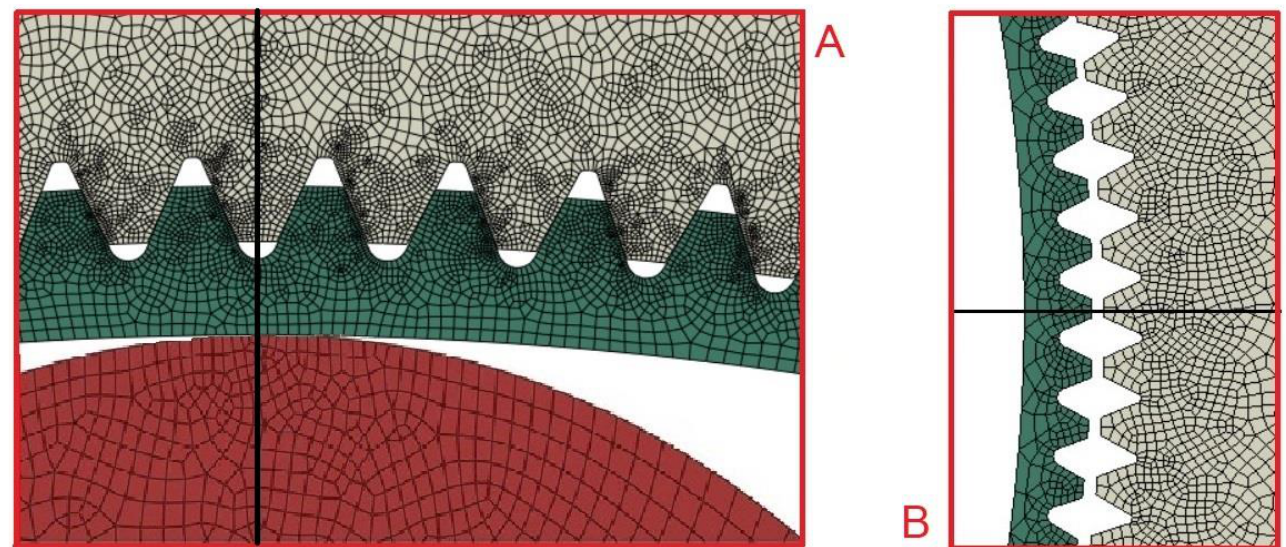
Figure 9. Characteristic area of computational model of harmonic drive: ( A ) meshed toothed wheel rims (major axis), ( B ) pass each other of teeth (minor axis).